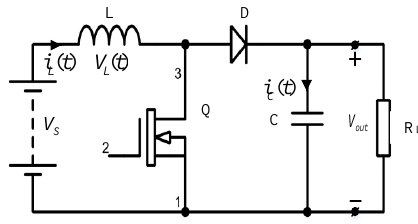
meet the power consumption needed. The solution is to integrate a DC-DC booster converter that significantly increases the output voltage and current of the PV panels. The conventional boost converter has often some main components such as one inductor, the diode, the capacitor, and the MOSFET transistor as shown in Fig. 3. The boost converter has two modes equivalent to the opening and closing process of the MOSFET transistor.